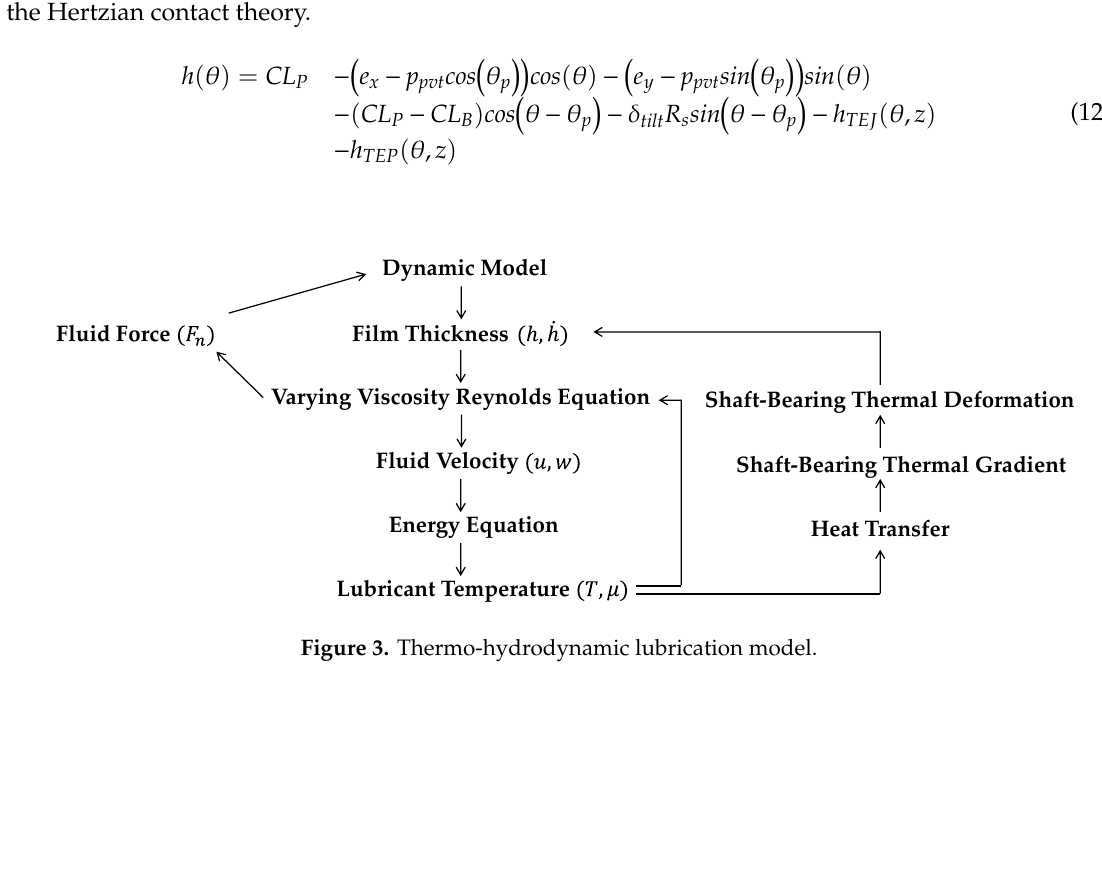
Figure 4. Schematic diagram for the calculation of the fluid film thickness.